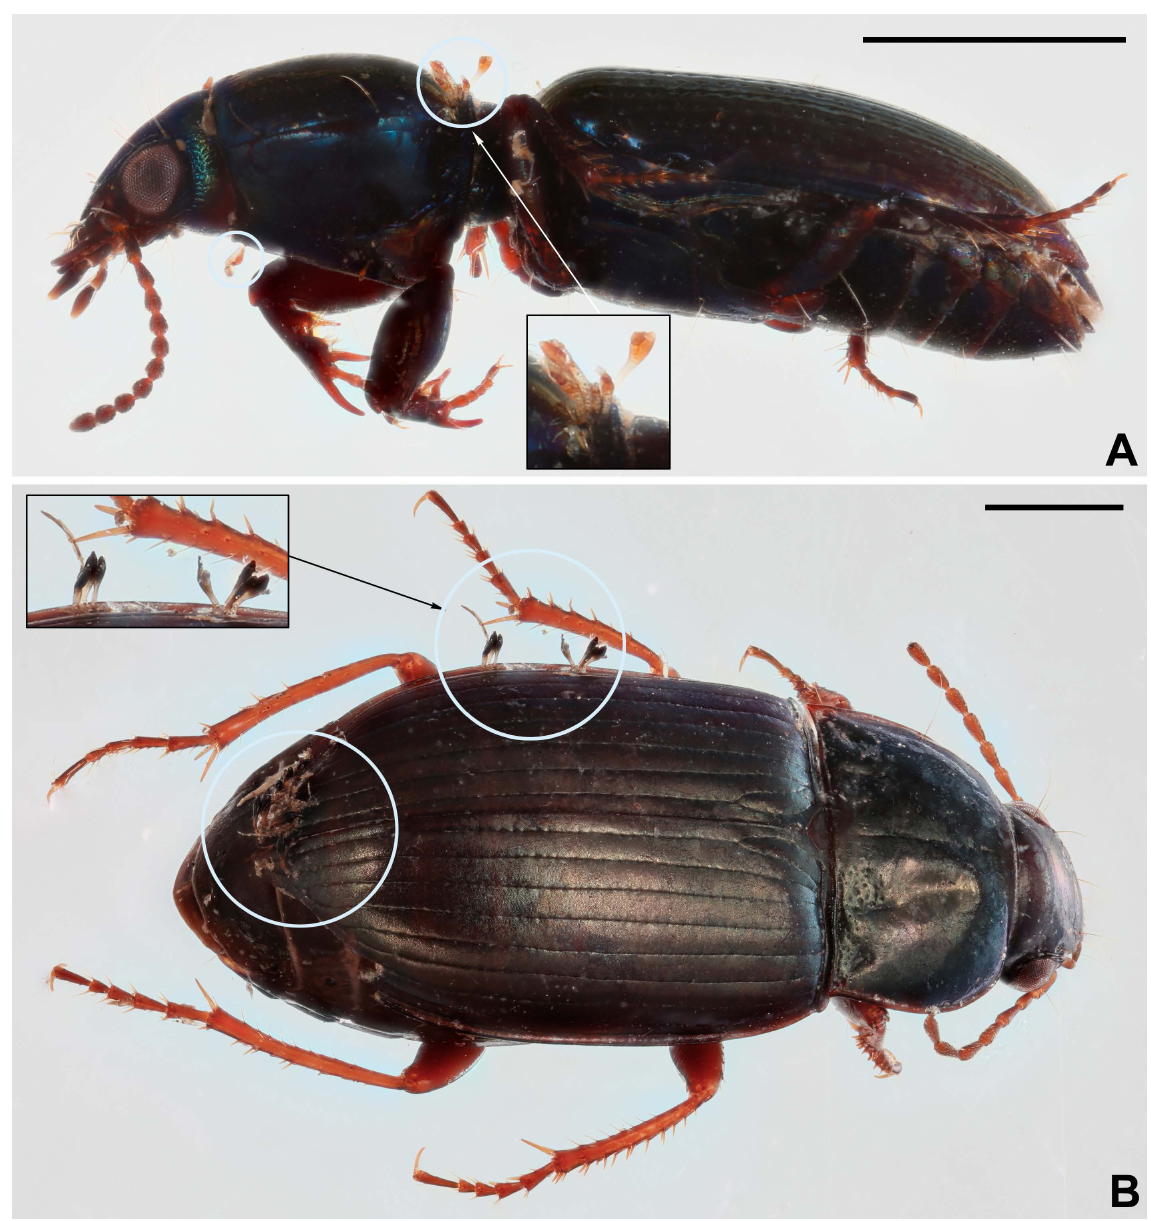
Fig. 103. Habitus of hosts with fungi. Some thalli are zoomed in, and others are encircled. A . Dyschirius salinus with thalli of Misgomyces dyschirii on various parts of the pronotum. B . Amara municipalis with a few mature thalli of Laboulbenia aubryi on left side of the elytra and many immature on the elytral apices. Scale bars: 1 mm. (Photos: Aslak Kappel